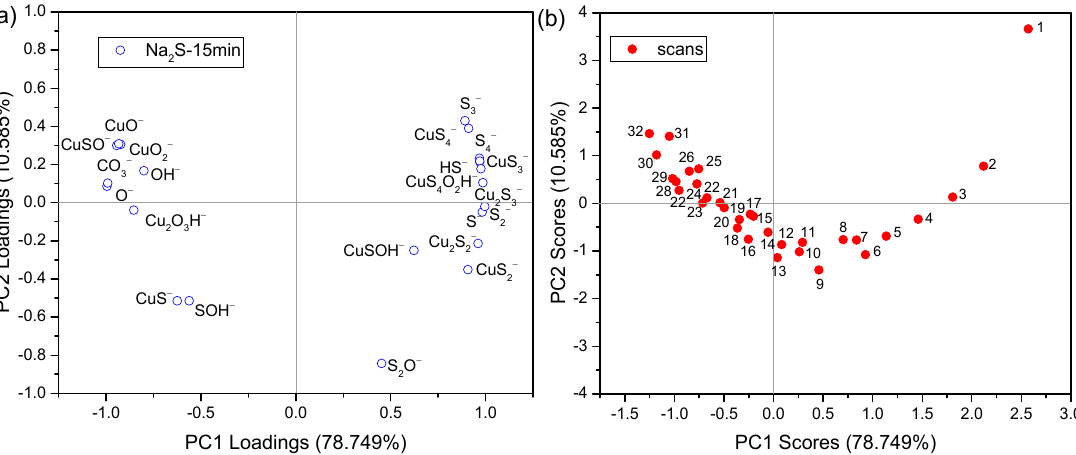
Figure 4. Principal component analysis results for TOF-SIMS negative spectra of sulfidized malachite at 32 different depths. ( a ): Loadings plot of PCs 1 and 2; ( b ): Scores plot of PCs 1 and 2.